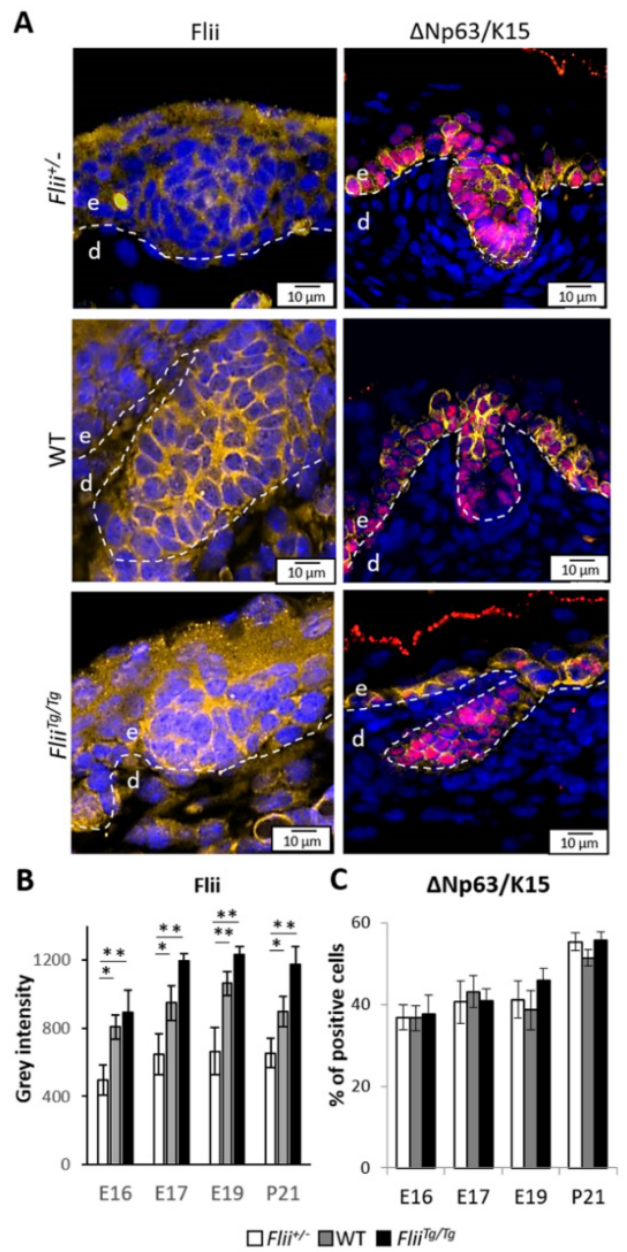
Figure 2. Alteration of Flii expression does not affect EpSC number during embryonic development. ( A ) Immunofluorescence detection of Flii, ∆ Np63 and K15 positive cells in developing epidermis at E17. Flii shown as pseudo-stained yellow, ∆ Np63 + K15 + positive cells shown as pseudo-stained pink and yellow. Nuclear DAPI staining shown as pseudo-stained blue. The epidermal-dermal junction shown by white dash lines; e, epidermis; d, dermis. Scale bars, 10 μ m. Flii +/ − , Flii knockdown; WT, wild-type; Flii Tg / Tg , Flii overexpressing. Quantification of ( B ) Flii expression as grey intensity in the epidermis, ( C ) Number of progenitor cells as % of ∆ Np63 + K15 + cells in total basal cells at E16, E17, E19 and P21. N = 6. Mean ± SEM. * p < 0.05. ** p < 0.005.